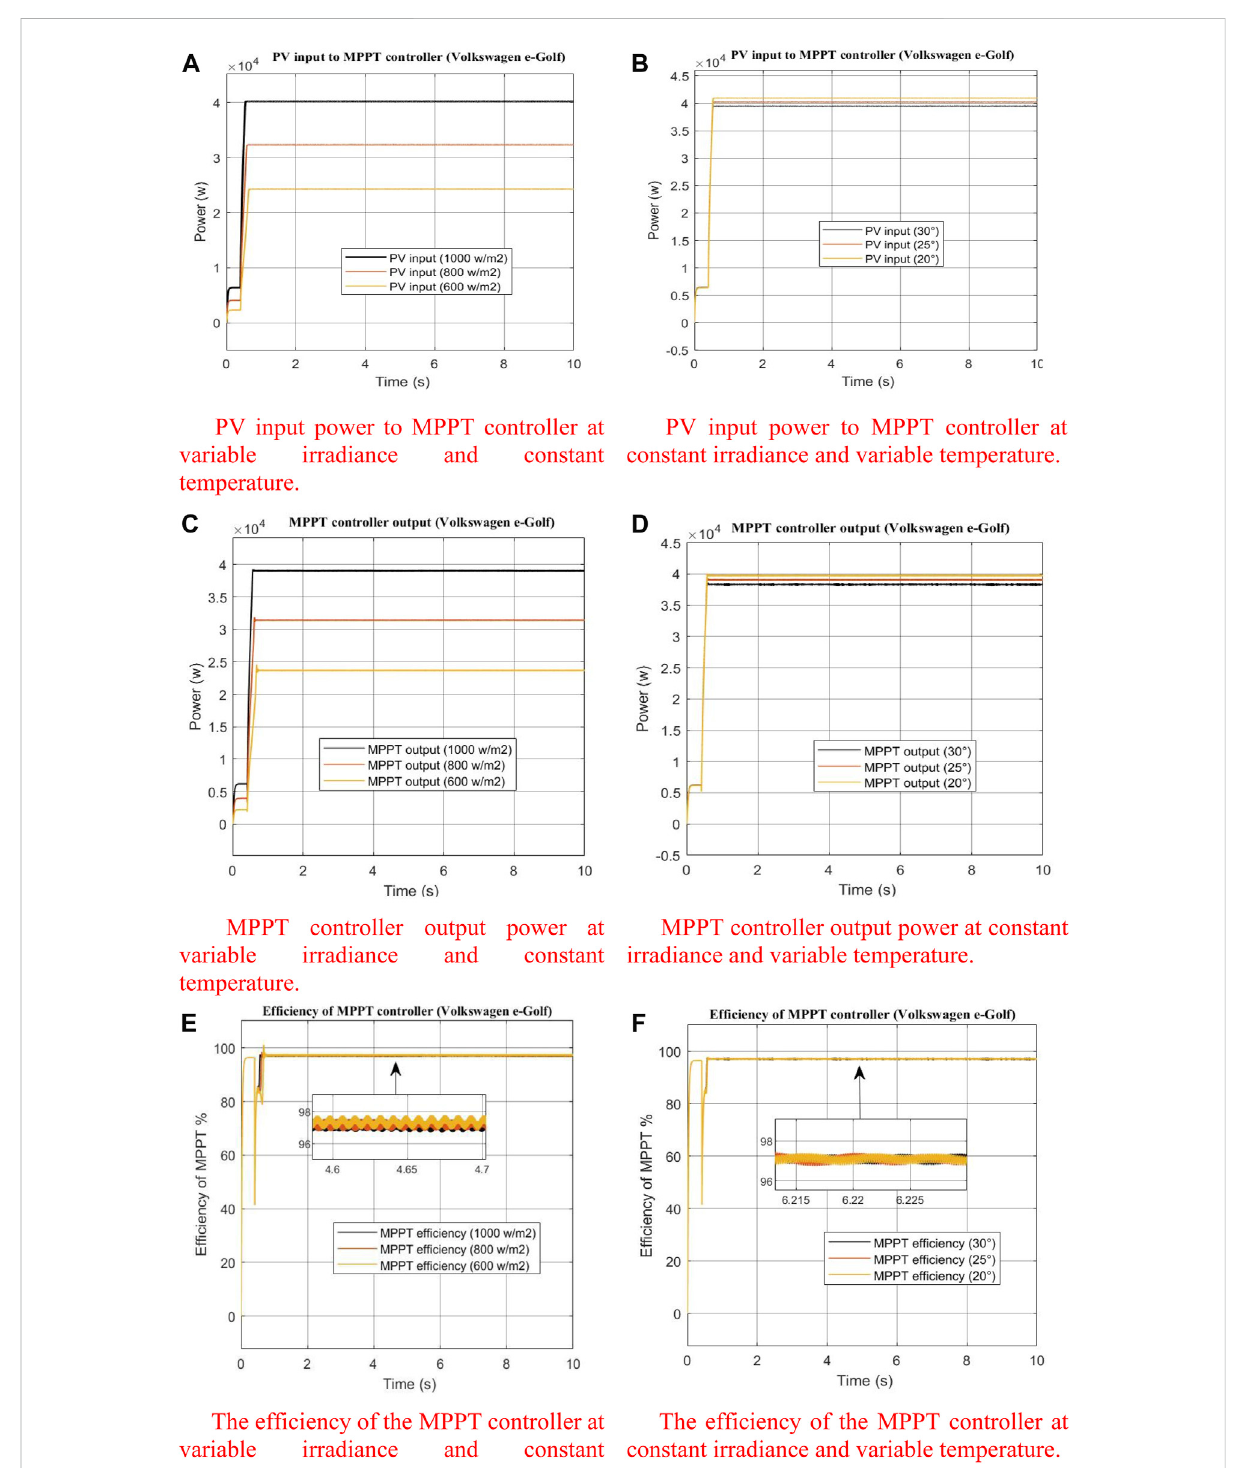
FIGURE 11 Simulation results of the MPPT controller for Volkswagen e-Golf. (A) PV input power to MPPT controller at variable irradiance and constant temperature. (B) PV input power to MPPT controller at constant irradiance and variable temperature. (C) MPPT controller output power at variable irradiance and constant temperature. (D) MPPT controller output power at constant irradiance and variable temperature. (E) Ef fi ciency of the MPPT controlleratvariableirradianceandconstanttemperature. (F) Ef fi